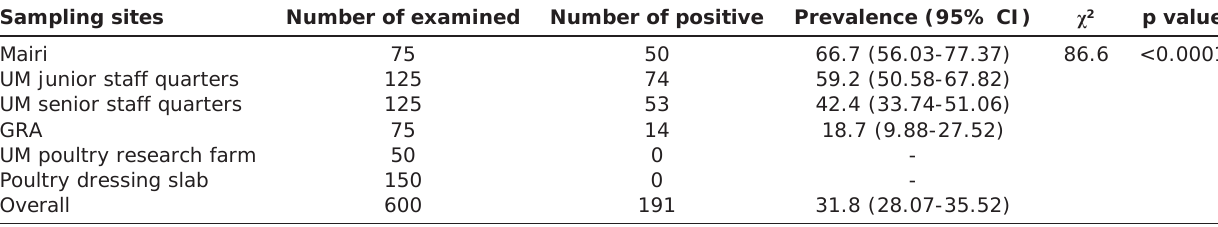
Table-2: Prevalence of avian coccidiosis according to various sampling sites in Maiduguri metropolis, Northeastern Nigeria. Sampling sites